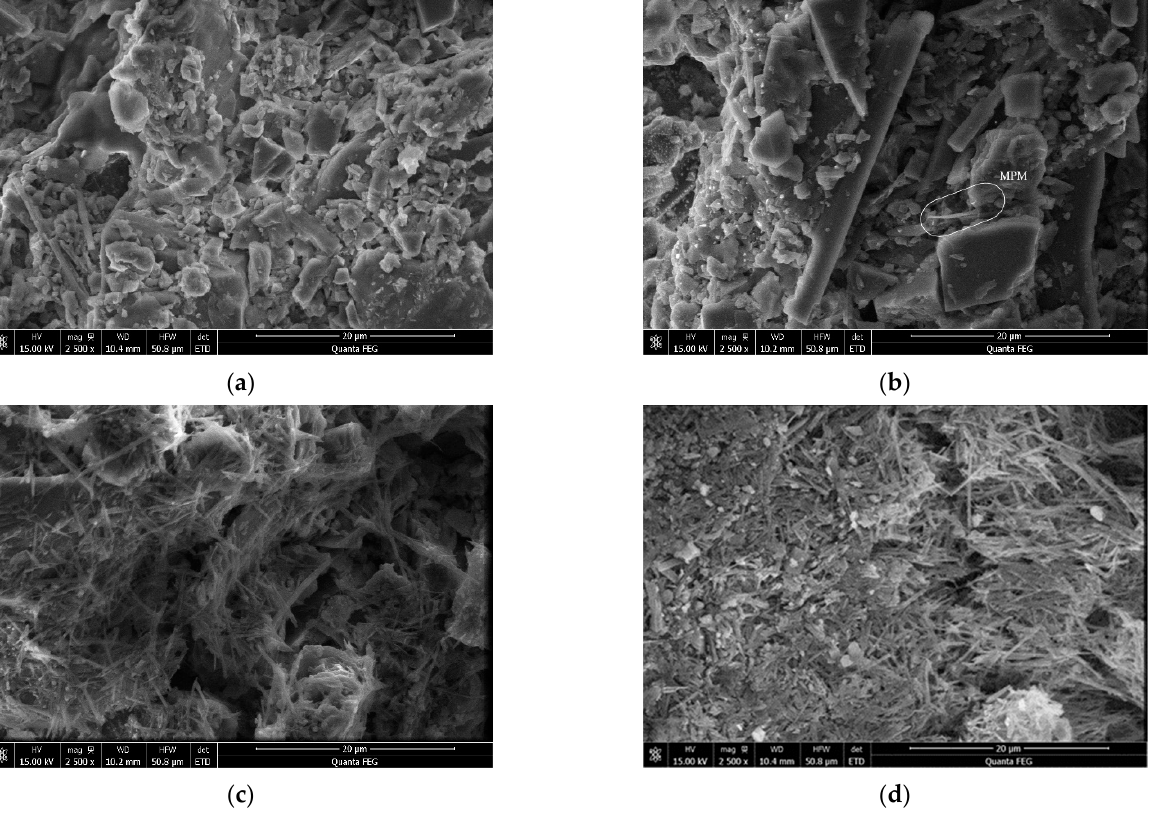
Figure 3. SEM images of the morphologies of photocatalytic putty powder with different PFWC spray amounts: ( a ) pure putty powder; ( b ) PFWC-63/putty powder; ( c ) PFWC-133/putty powder; ( d ) PFWC-439/putty powder.